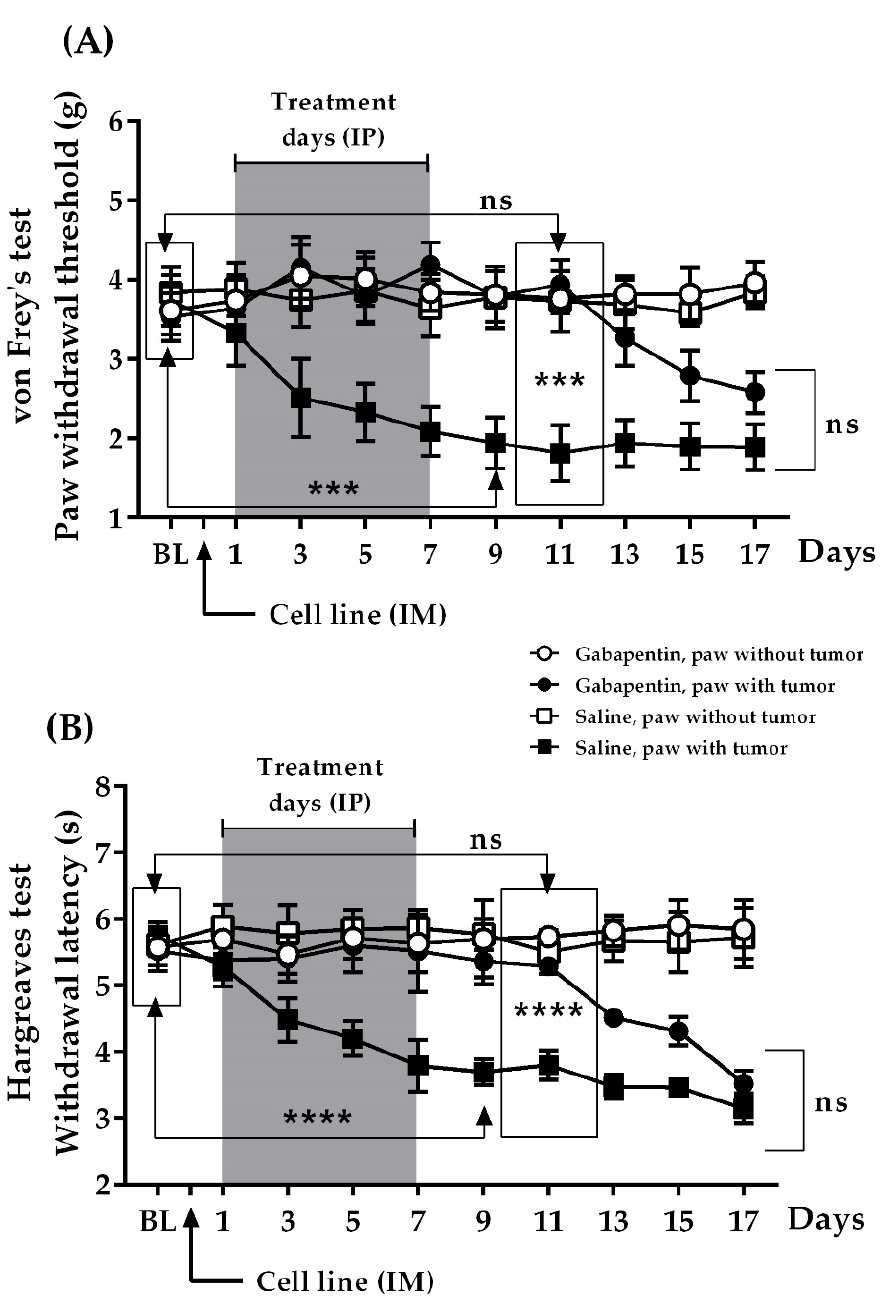
Figure 3. Preventive protocol: Gabapentin (100 mg/Kg) or saline was administered IP (days 1–7, grey box) to evaluate their effects on nociceptive responsiveness caused by tumor progression: ( A ) von Frey test; ( B ) Hargreaves test. BL: Baseline (response value before IM inoculation of the cell line and before starting treatment). Contralateral non-inoculated limbs were used as internal controls.